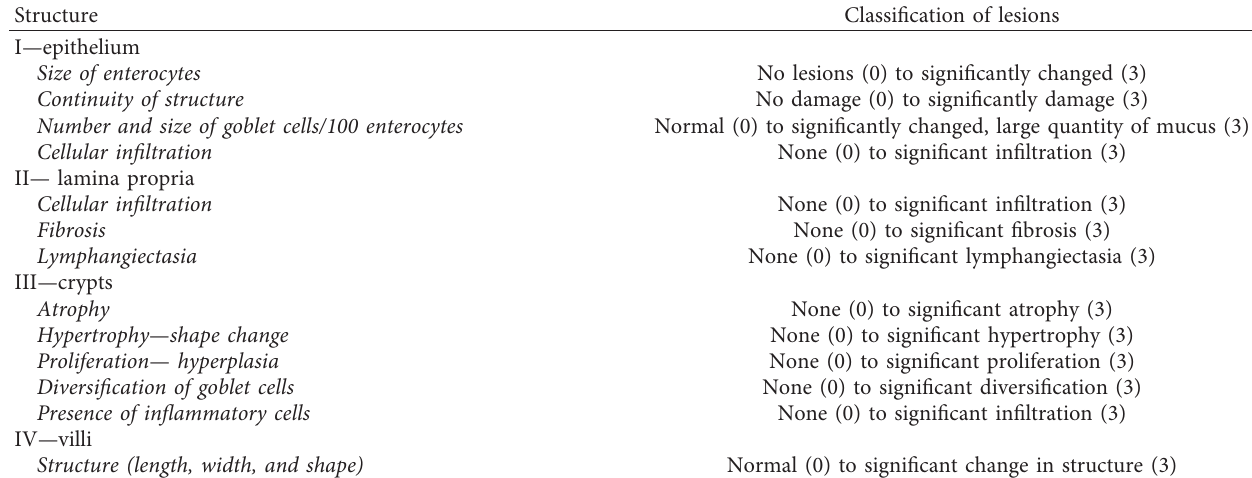
Table 1: Criteria for histopathological evaluation of the GI